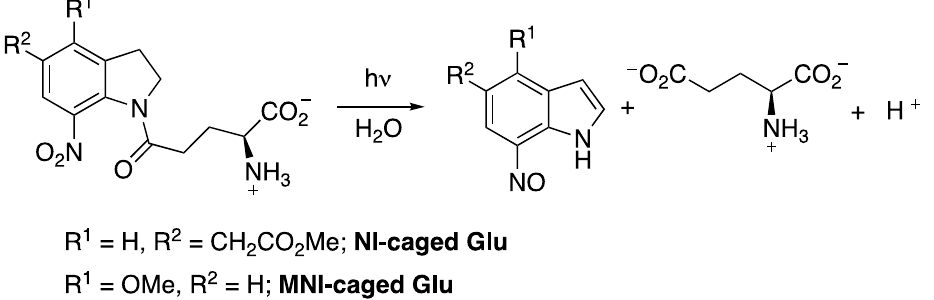
Figure 2. Overall reaction for the photolysis of NI- or MNI-caged glutamate in aqueous solution.